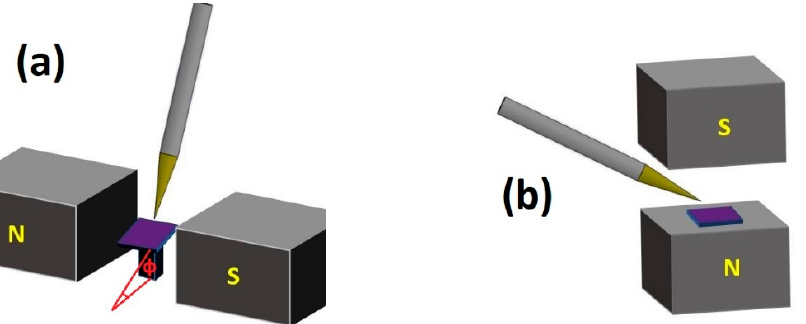
Figure 2. Schematics of drop casting in a magnetic field ( a ) under an applied field of 0.11 T parallel to the substrate, which is tilted by an angle of φ to the horizontal plane ( b ) under a field of perpendicular to the substrate.